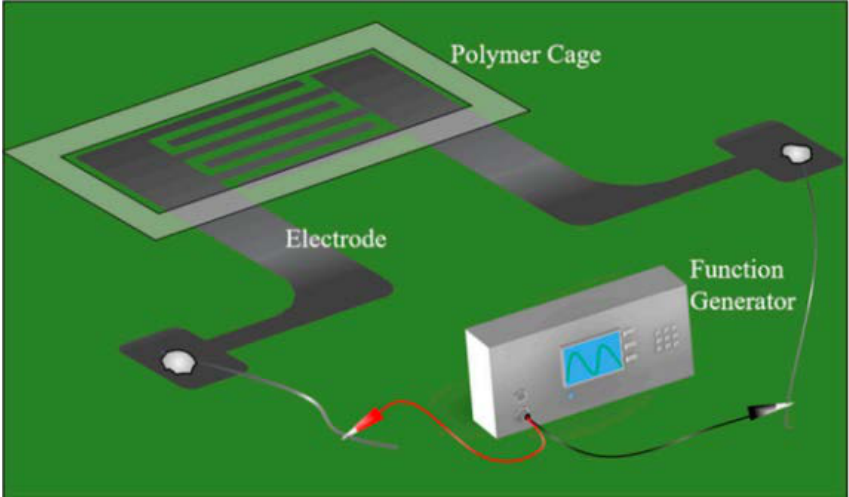
Figure 2. Sketch of the experimental setup including IDEAs connected to a function generator.